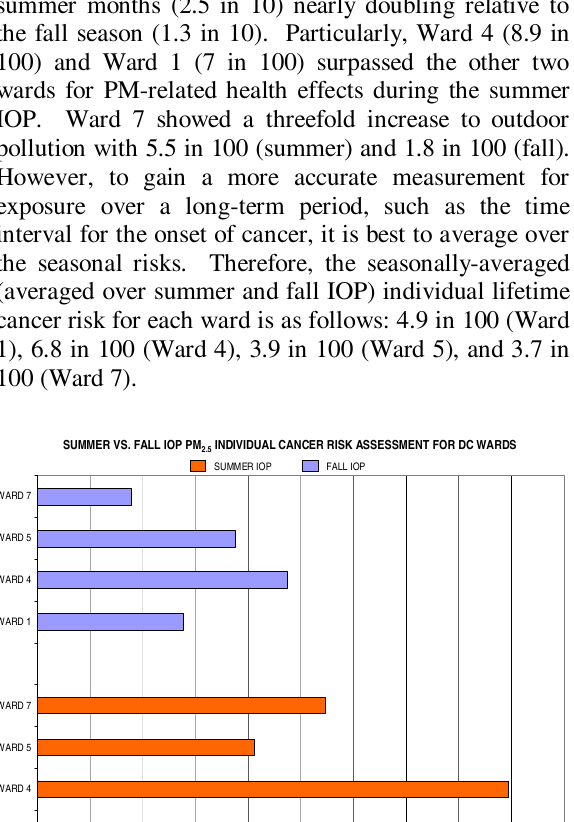
Figure 9: Summer IOP vs. Fall IOP for PM Excess Cancer